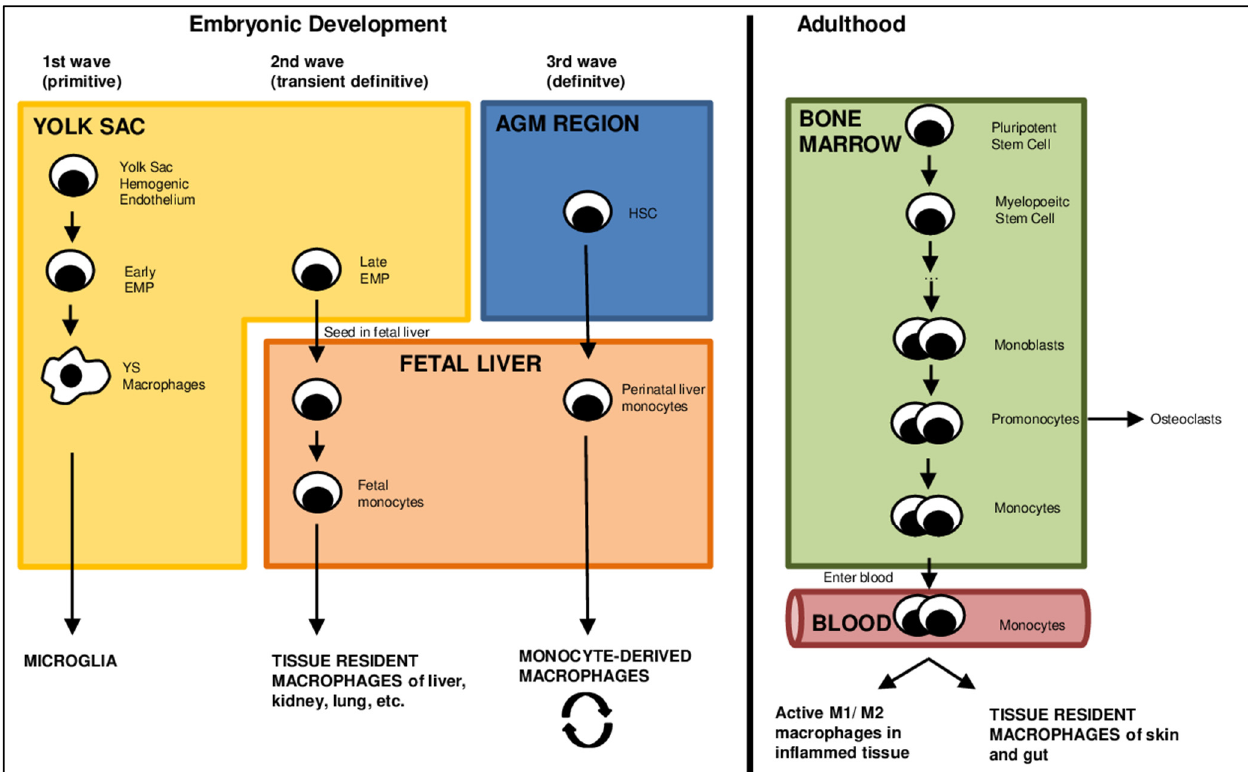
Figure 1. Formation and differentiation of macrophages. Schematic depiction of the differentiation of monocytes during embryonic development unfolding in three sequential waves and adulthood as well as their further differentiation to different subpopulations of macrophages in the tissue [25] (AGM region: aorta-gonad-mesonephros region; EMP: Erythro-Myeloid Progenitors, YS: yolk sac), modified after Corliss et al. [26].